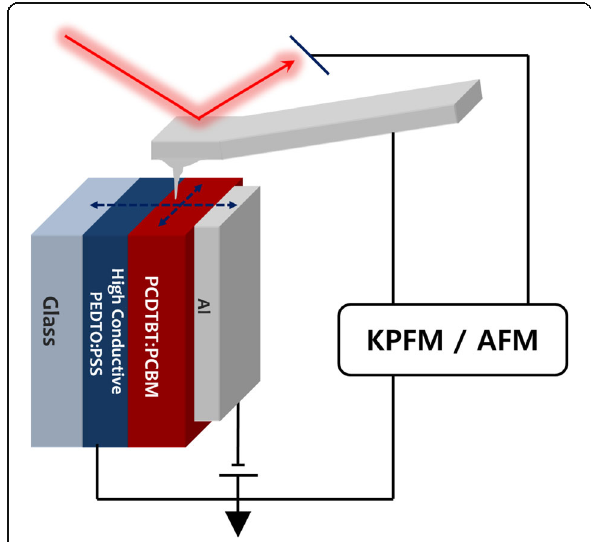
Fig. 1 Device configuration and experimental setup for cross- sectional KPFM